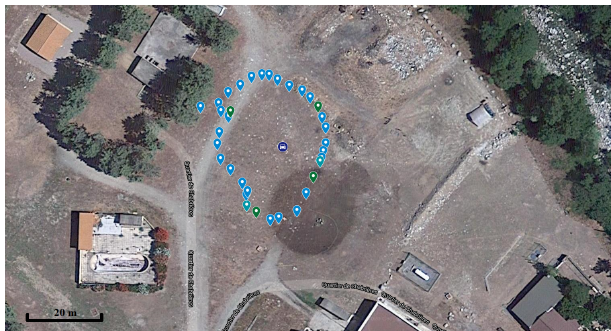
Figure 17. Drone and car positions registered by global positioning system (GPS) sensors. The light blue icons represent the positions of the drone during the test, the green icons represent the positions of the drone when the picture was captured, and the dark blue icon represents the position of the